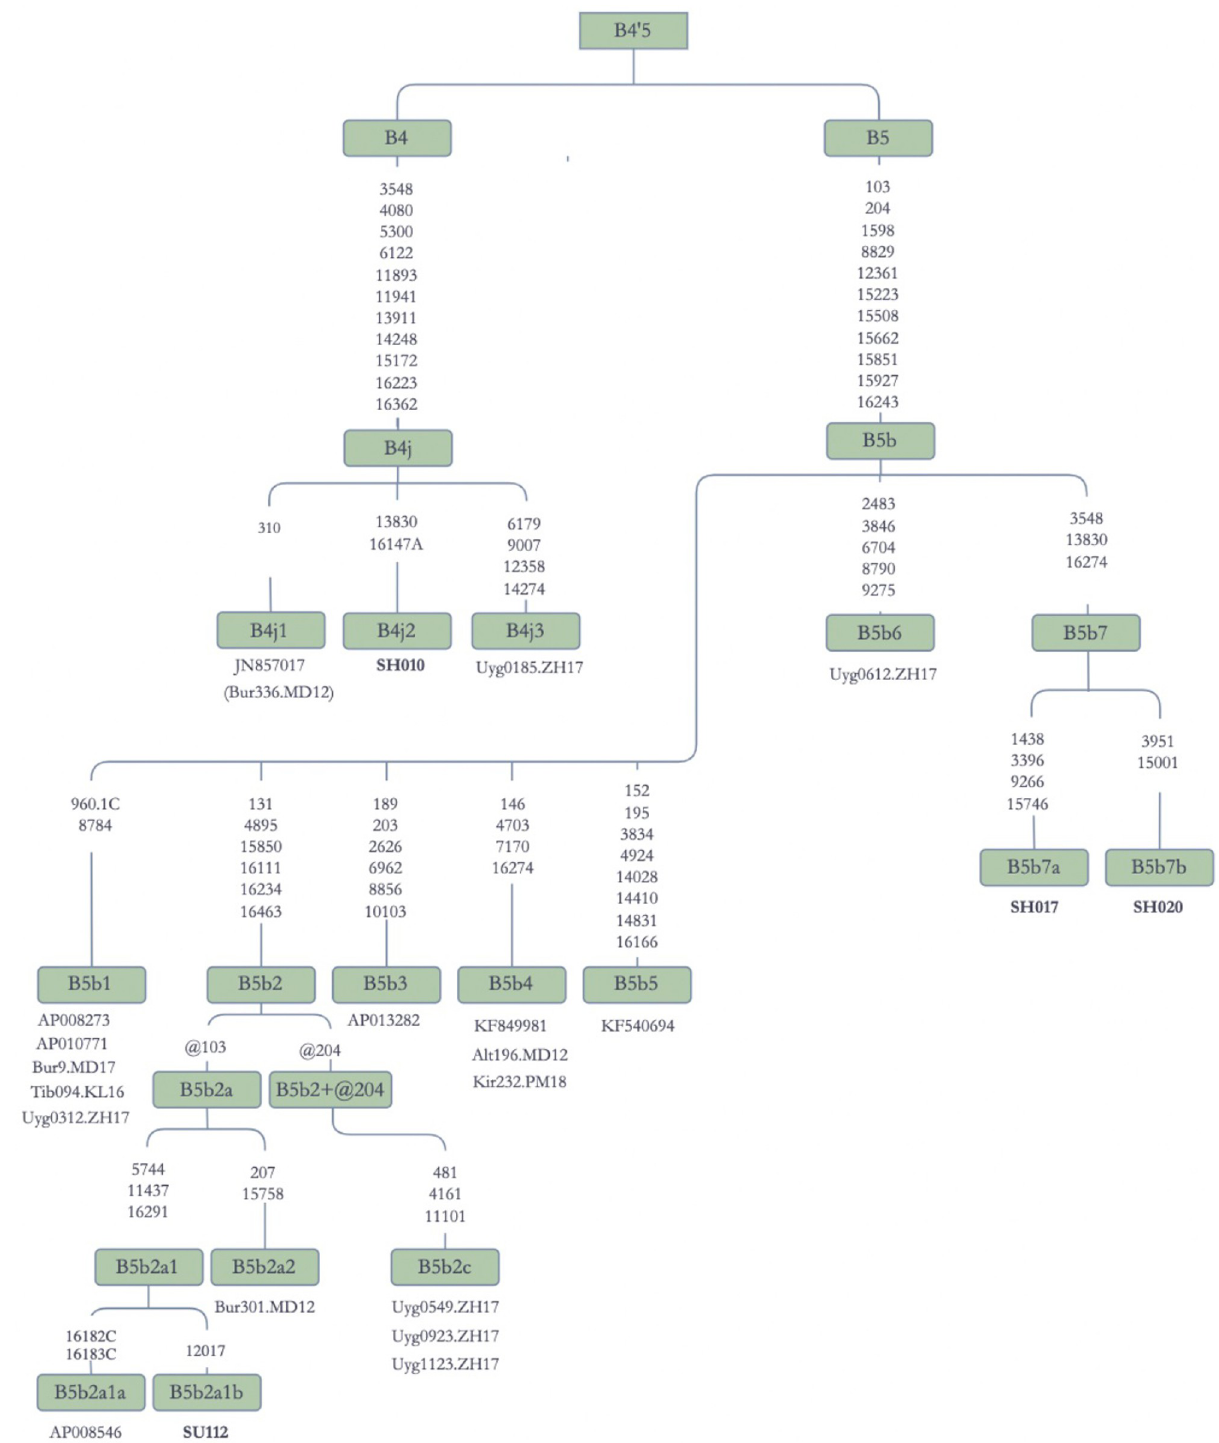
Fig 6. Schematic phylogenetic tree for the haplogroup B mitochondrial genomes. Note: Alt: Altaian; Bur: Buryat; Uyg: Uyghur; Kir: Kirghiz; Tib: Tibetan.